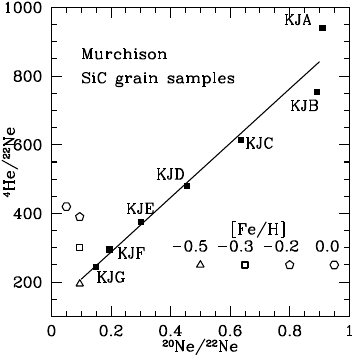
Figure 1. Isotopic ratios of light noble gases in SiC grain admixtures from the Murchison chondrite (filled squares) versus model predictions of the He-rich layers in AGB stellar models (open symbols). The data indicate the presence in the samples of a very large anomaly (Ne-E(H)) with respect to the average solar system ratios, which are: ( 4 He / 22 Ne) (cid:4) = 1.18 × 10 4 ; ( 20 Ne / 22 Ne) (cid:4) = 13.67 [17]. AGB stars of lower-than-solar composition were shown by [15] to account for the abundances in the KJG samples, those more heavily treated with acids (hence cleaner from solar-system contaminations). The other samples lay on a linear mixing sequence between purely stellar and solar